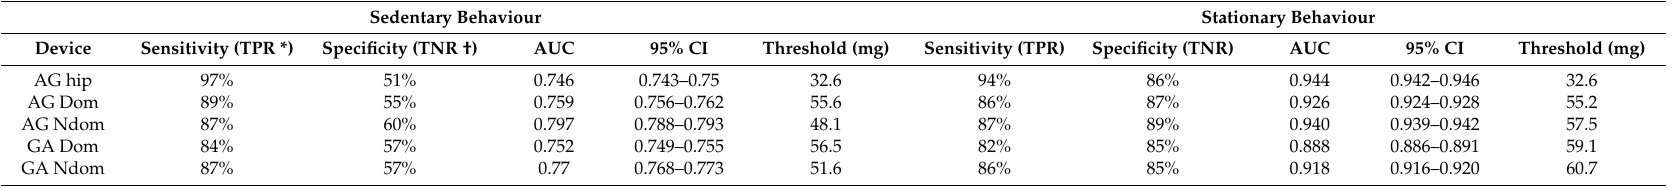
Table 5. Sensitivity, specificity, area under the curve (AUC) and 95% confidence intervals (CI), with proposed thresholds for ActiGraph (AG) hip, dominant- (Dom) and non-dominant (Ndom) wrists as well as GENEActiv (GA) dominant and non-dominant wrists in children.